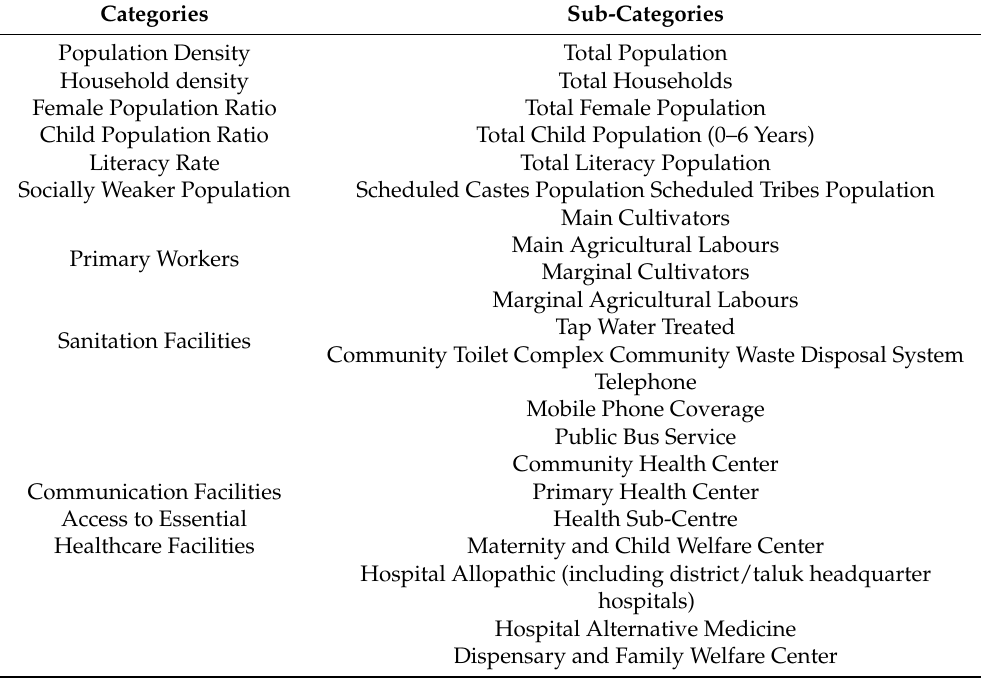
Table 2. Indicators extracted from Census of India datasets for vulnerability assessment at micro- administrative